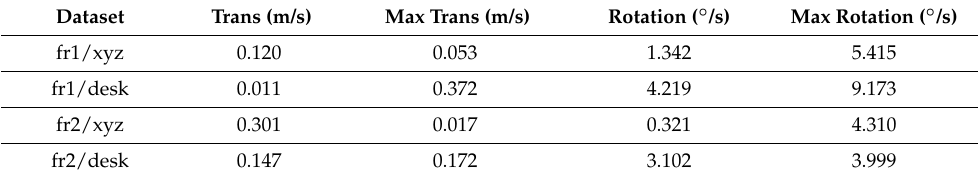
Table 2. Relative pose error (RPE) evaluation of proposed approach against Vicon outputs.